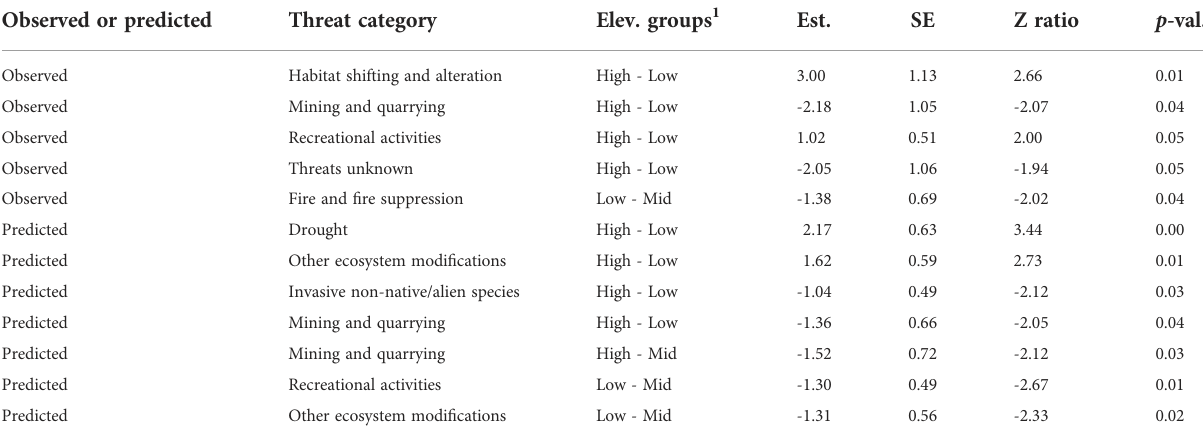
TABLE 2 Signi fi cant (p <0.05) differences in likelihood of observation or prediction for known threats among elevation groups. Observed or